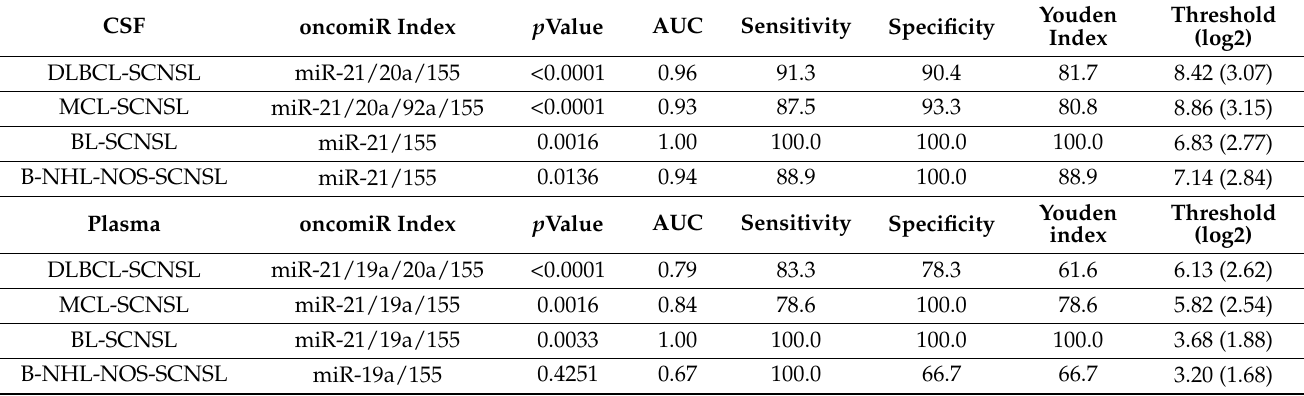
p value (the effect of oncomiR indices on CNS lymphoma involvement, likelihood ratio test of the multivariate regression analysis), AUC (the area under curve of Receiver Operating Characteristics), specificity, sensitivity, Youden index (the highest sum of specificity and sensitivity—100), and threshold (the cut-off value for lymphoma CNS involvement) all detect CNS lymphoma vs. systemic lymphoma involvement.